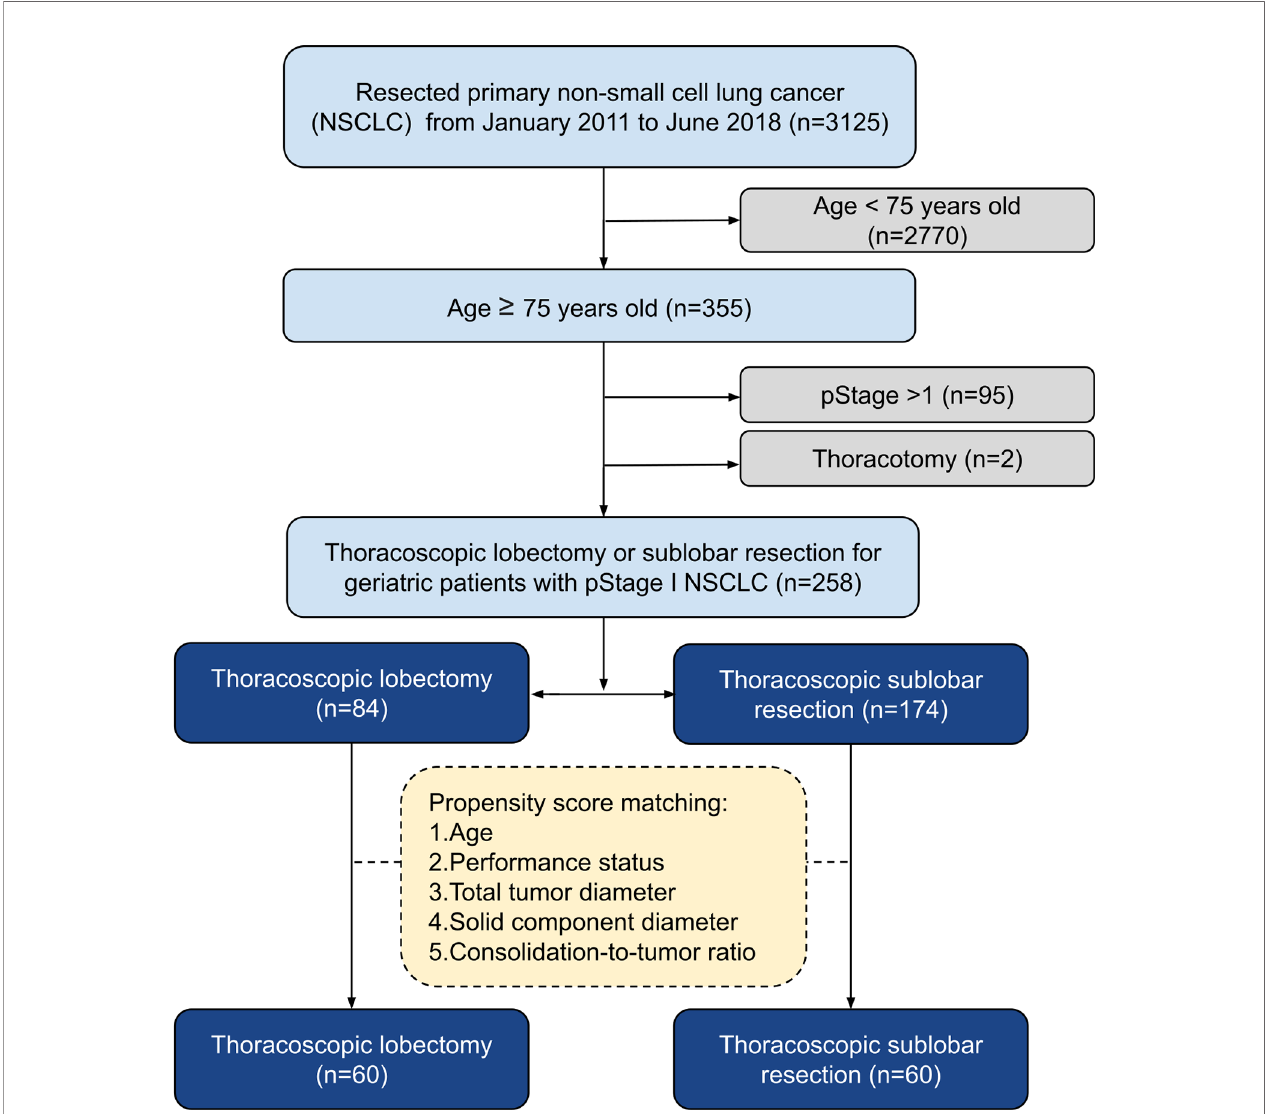
FIGURE 1 | Algorithm for patient selection. NSCLC, Non-small cell